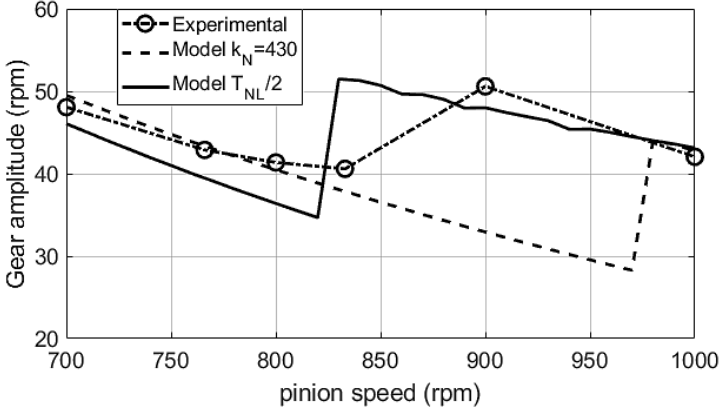
Figure 11. Experimental results of peak-to-peak gear amplitude compared with modelling results.